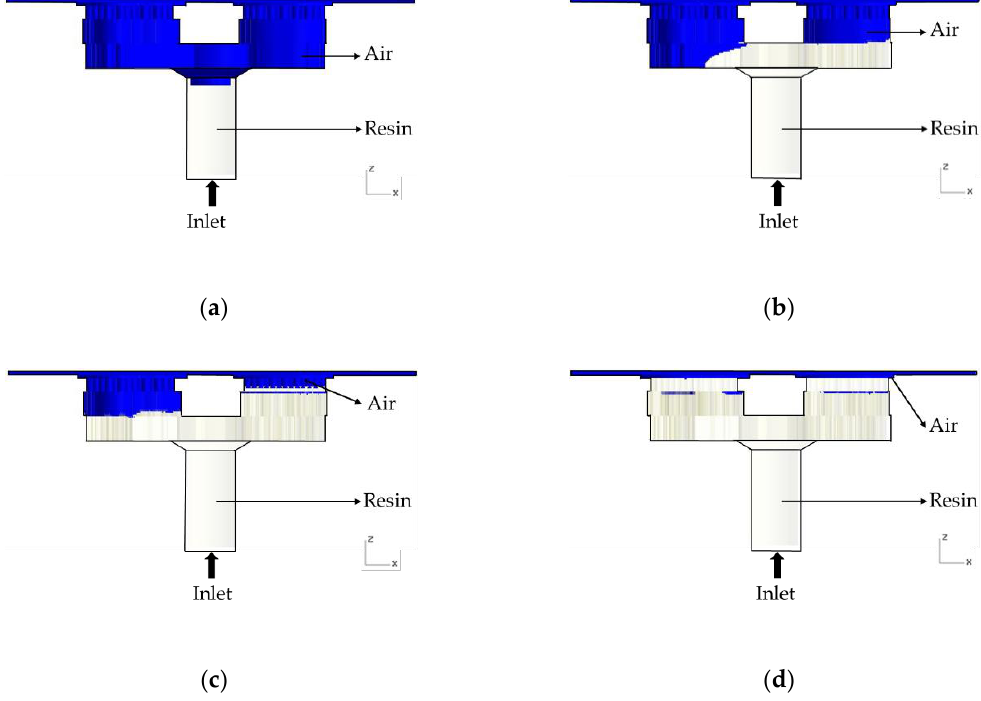
Figure B3. The flow rate is 0.04 cm 3 /sec. ( a ) Filling 10%; ( b ) Filling 30%; ( c ) Filling 50%; ( d ) Filling 329 70%.